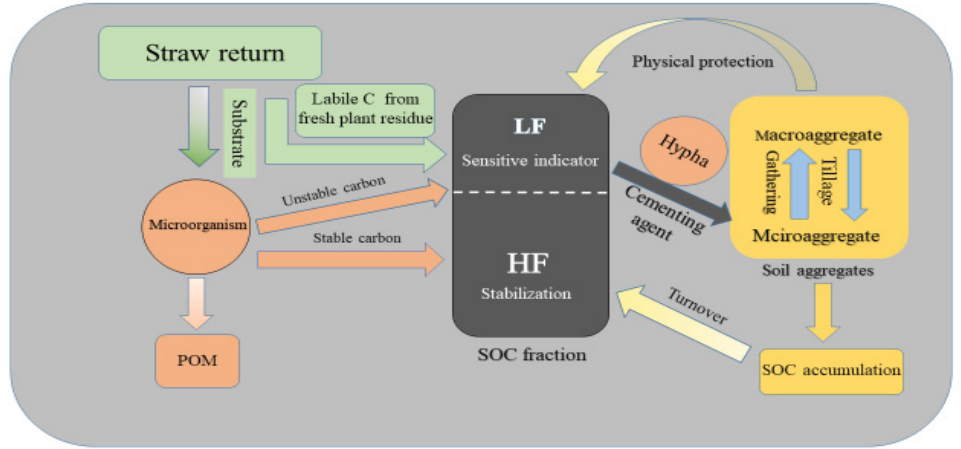
Figure 6. Graphical sketch of the effects of straw return for macroaggregates and microaggregates on the physical fractions of soil organic carbon (light and heavy fractions) and their transformation and microbial mechanisms. SOC, soil organic carbon; LF, light fraction; HF, heavy fraction; POM, particulate organic matter.